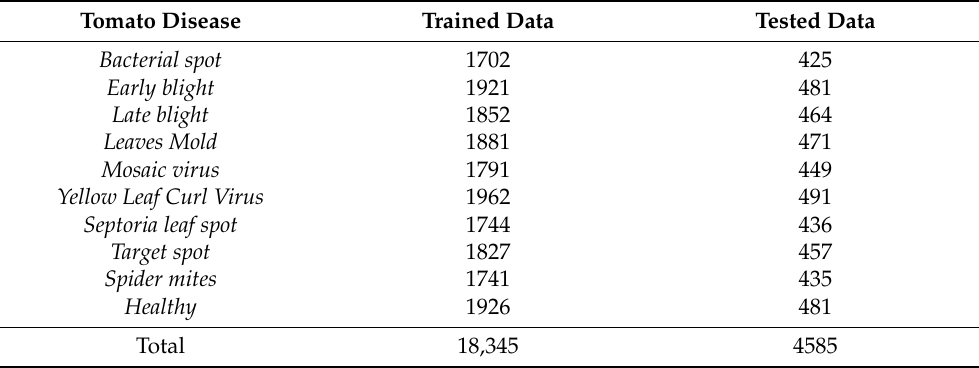
Table 1. The details of tomato diseases in the dataset [26] consisting of tested dataset and trained dataset.